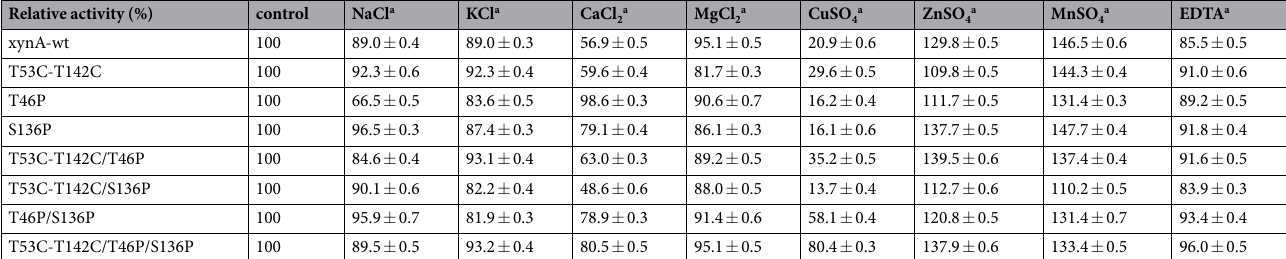
Table 4. Effects of metal ions and chemical reagents (10 mM) on β -xylanase activity. a Values are means ± standard deviation.